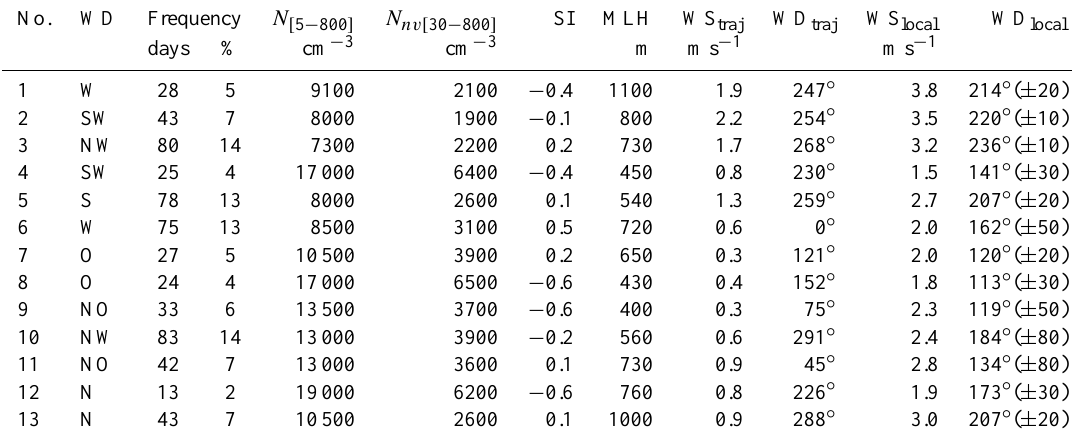
Table 2. Mean characteristics of the 13 back trajectory clusters. Season index (SI) reflects occurrence in winter ( − 1) or summer (+1). WD: wind direction, WS: wind speed, MLH: mixed layer height, N [ 5 − 800 ] : total particle number between 5 and 800nm, N nv [ 30 − 800 ] : particle number downstream of the thermodenuder (300 ◦ C) between 30 and